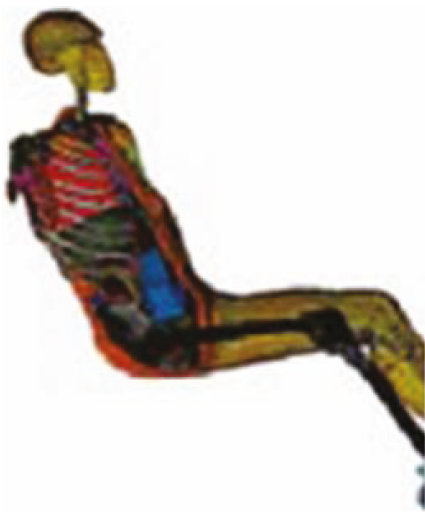
Figure 1: WSU model